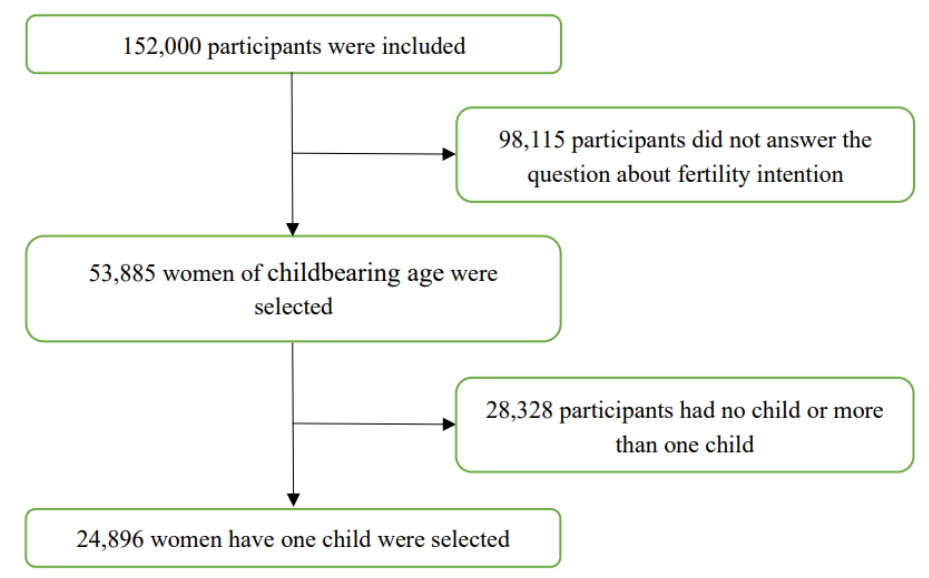
Figure 1. Flowchart of participant selection.